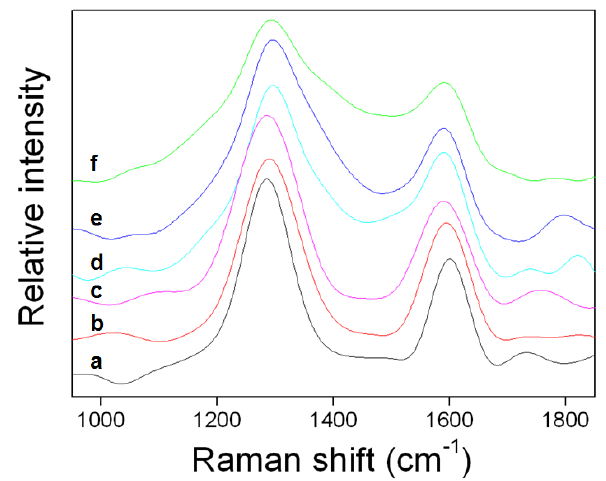
Figure 2. Raman spectra of ( a ) pristine CNTs; ( b ) activated NMCNTs; ( c ) NMCNTs-1000; ( d ) NMCNTs-900; ( e ) NMCNTs-800; and ( f ) NMCNTs-700.